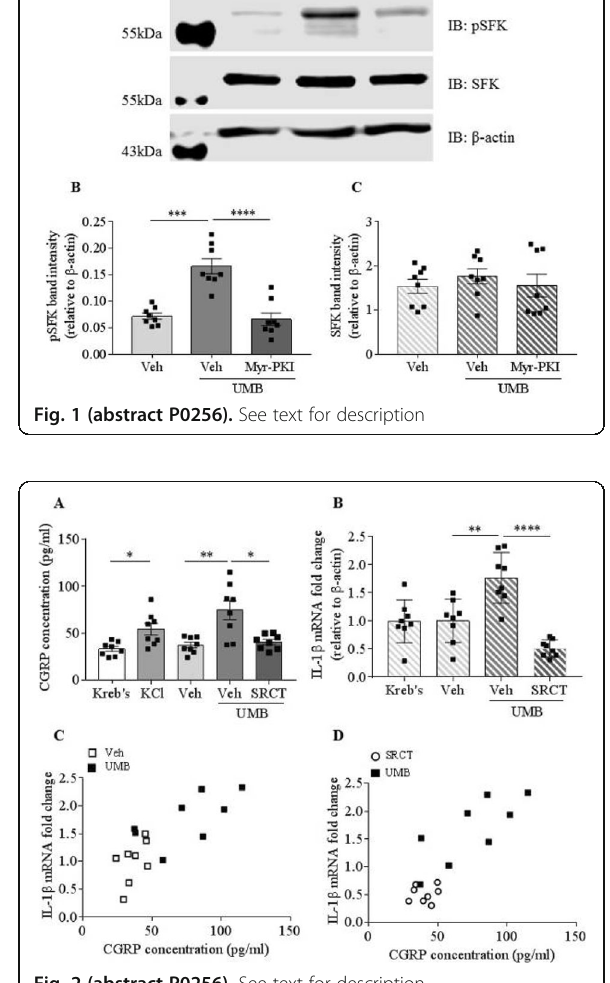
Fig. 2 (abstract P0256). See text for